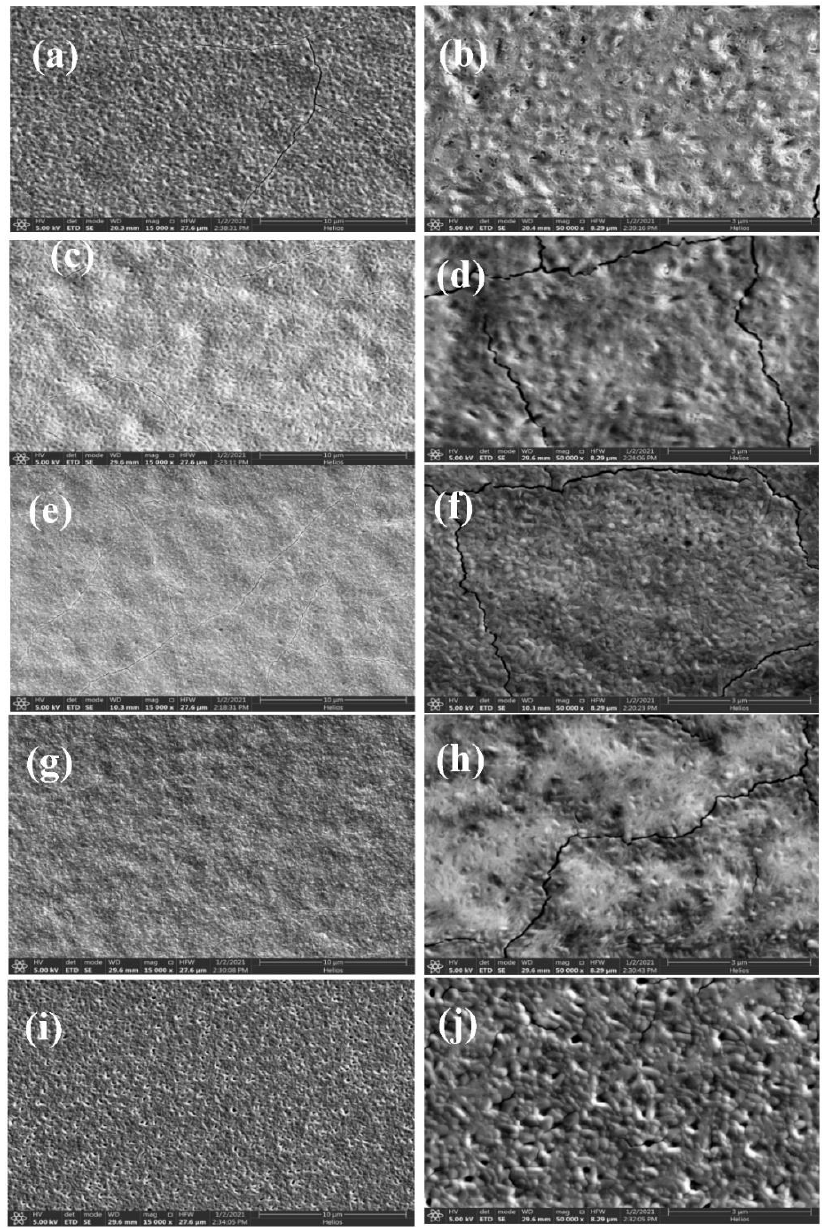
Figure 3. SEM top view of the multicomponent ferroelectric hybrid films. ( a , c , e , g , i ) are the ferroelec- tric films formed by [C 6 N 2 H 18 ]BiI 5 and [C 6 N 2 H 18 ]SbI 5 mixing ratios of 0.8:0.2, 0.6:0.4, 0.5:0.5, 0.4:0.6 and 0.2:0.8, in that order. ( b , d , f , h , j ) are enlarged views of ( a , c , e , g , i ),